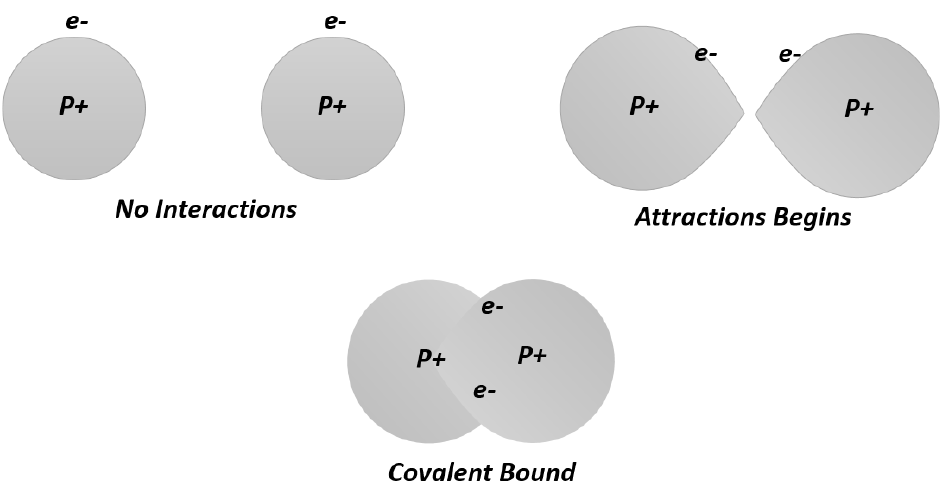
Figure 2. The formation of a covalent compound by means of two hydrogen atoms.